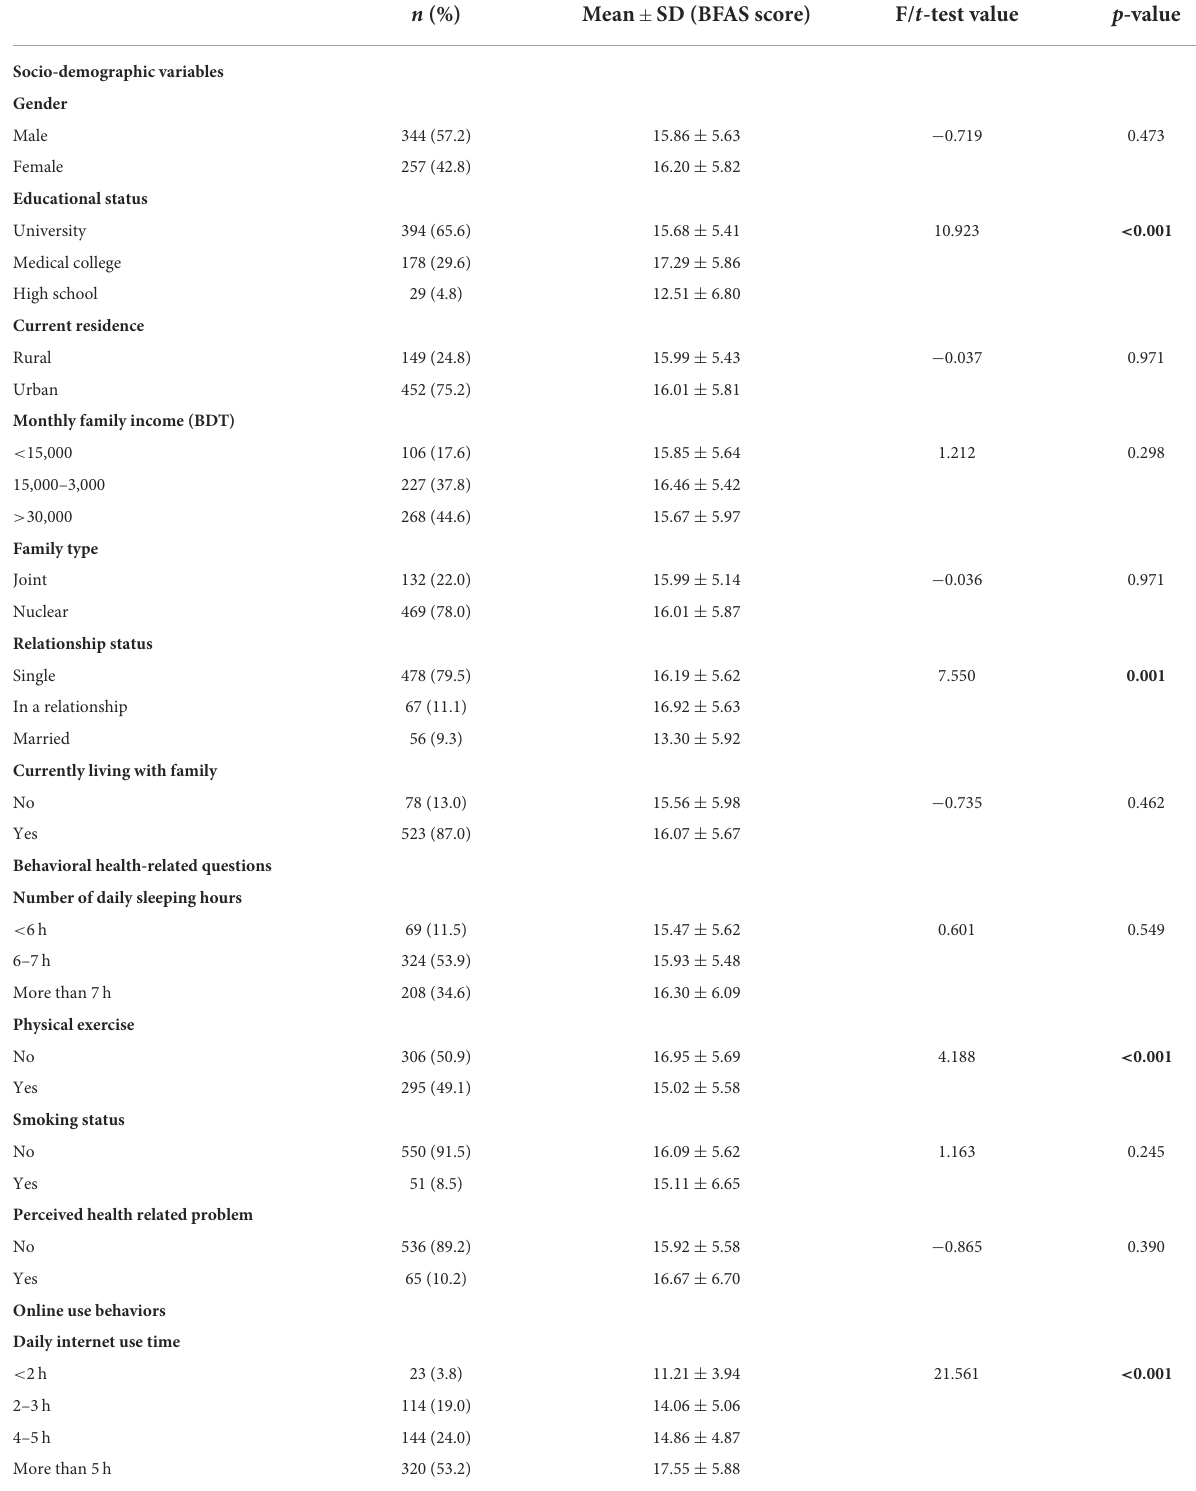
TABLE 1 Distribution of the studied variables with problematic Facebook